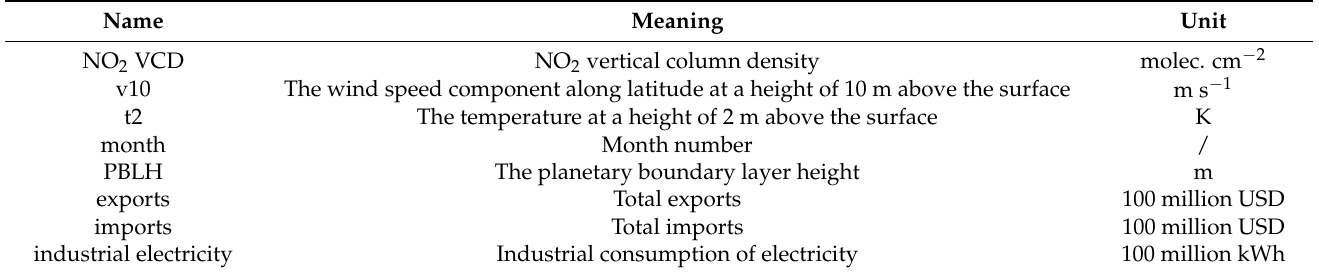
Table 1. The input variables for GAM modeling research of the three typical